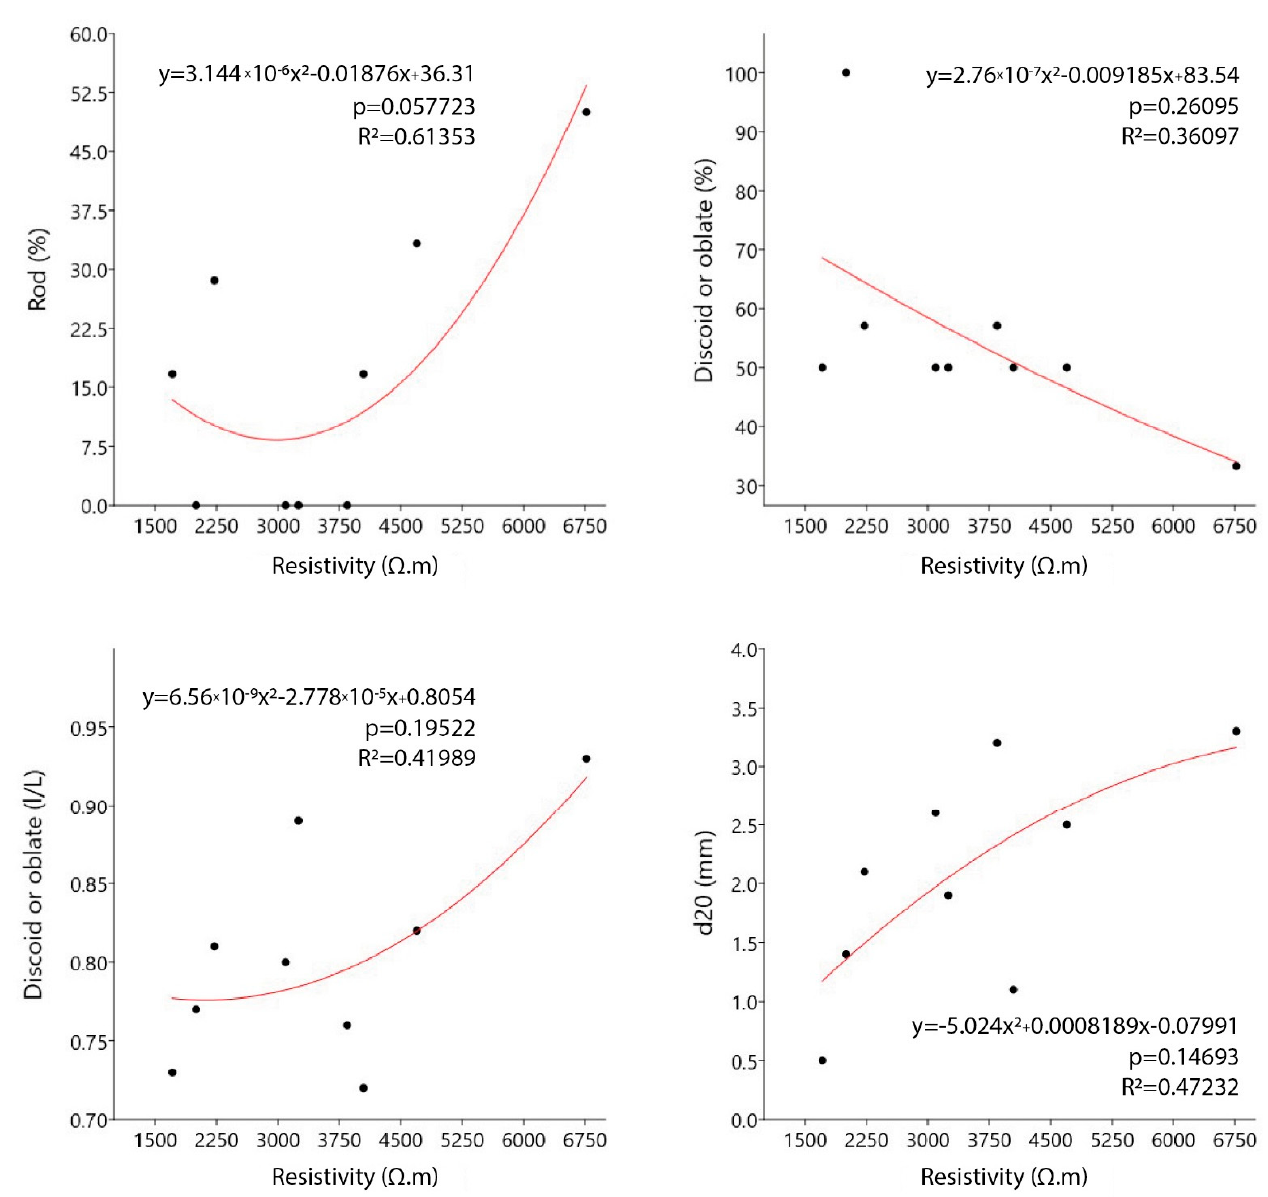
Figure 5. Regression models showing the relationships between resistivity and particle-shape variables.